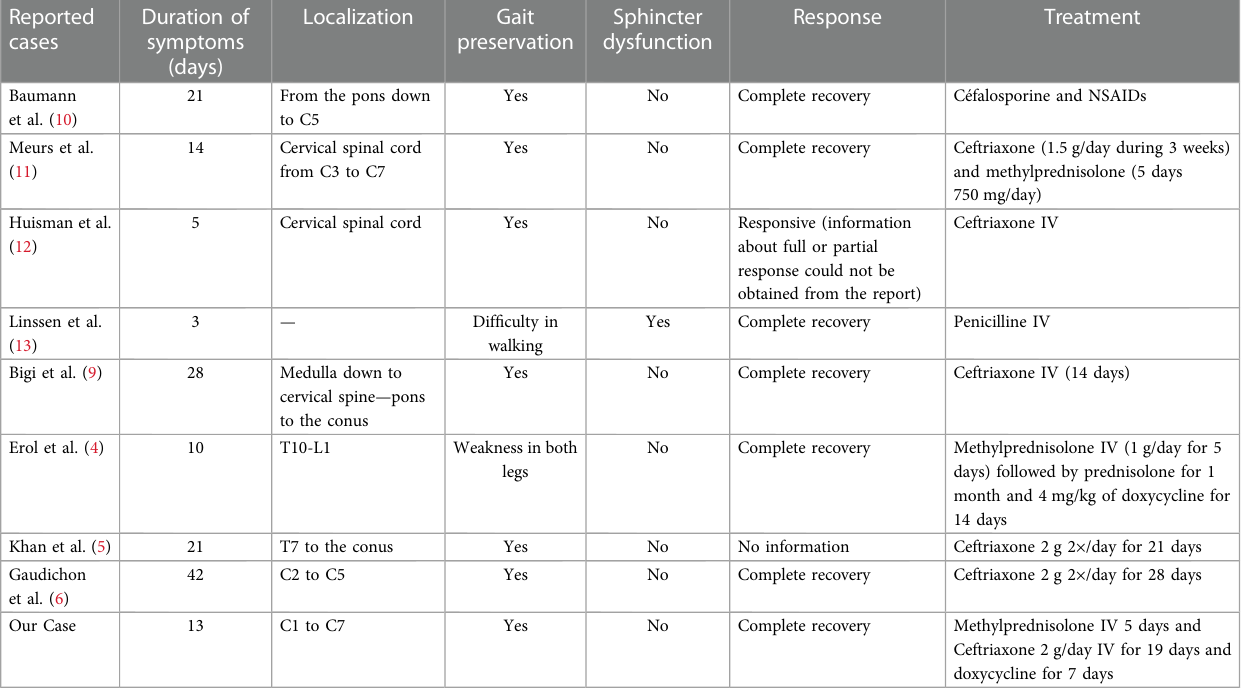
TABLE 1 Summary table of the different cases of patients with transverse myelitis caused by Lyme disease described in the literature, to which our patient case has been added. In this study, we were interested in determining the following: duration of symptoms, localization, gait preservation, sphincter disorder, response to